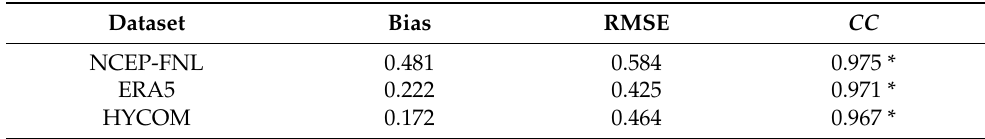
Table 3. Statistics on SST evaluation (unit: ◦ C). The base dataset is satellite MW_IR OISST product. The comparisons are performed during 2 November to 10 November. The SST of typhoon eye is considered. The asterisk in CC represents the CC passing 0.05 significant